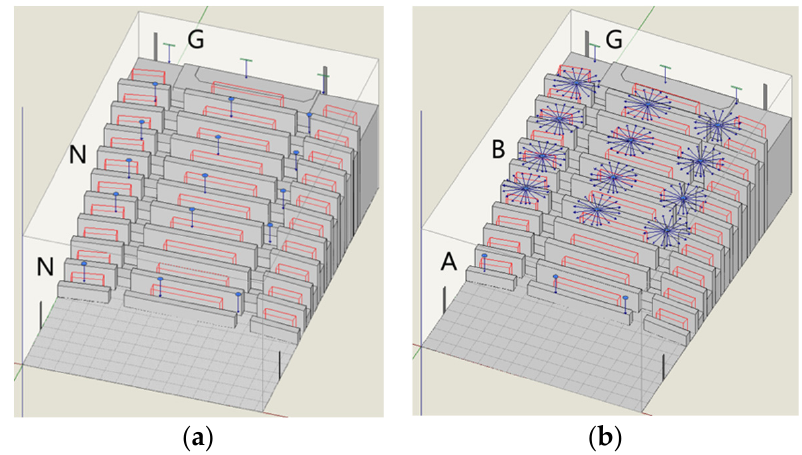
Figure 5. Distribution of air inlets in the model: ( a ) Scheme one; ( b ) Scheme two.